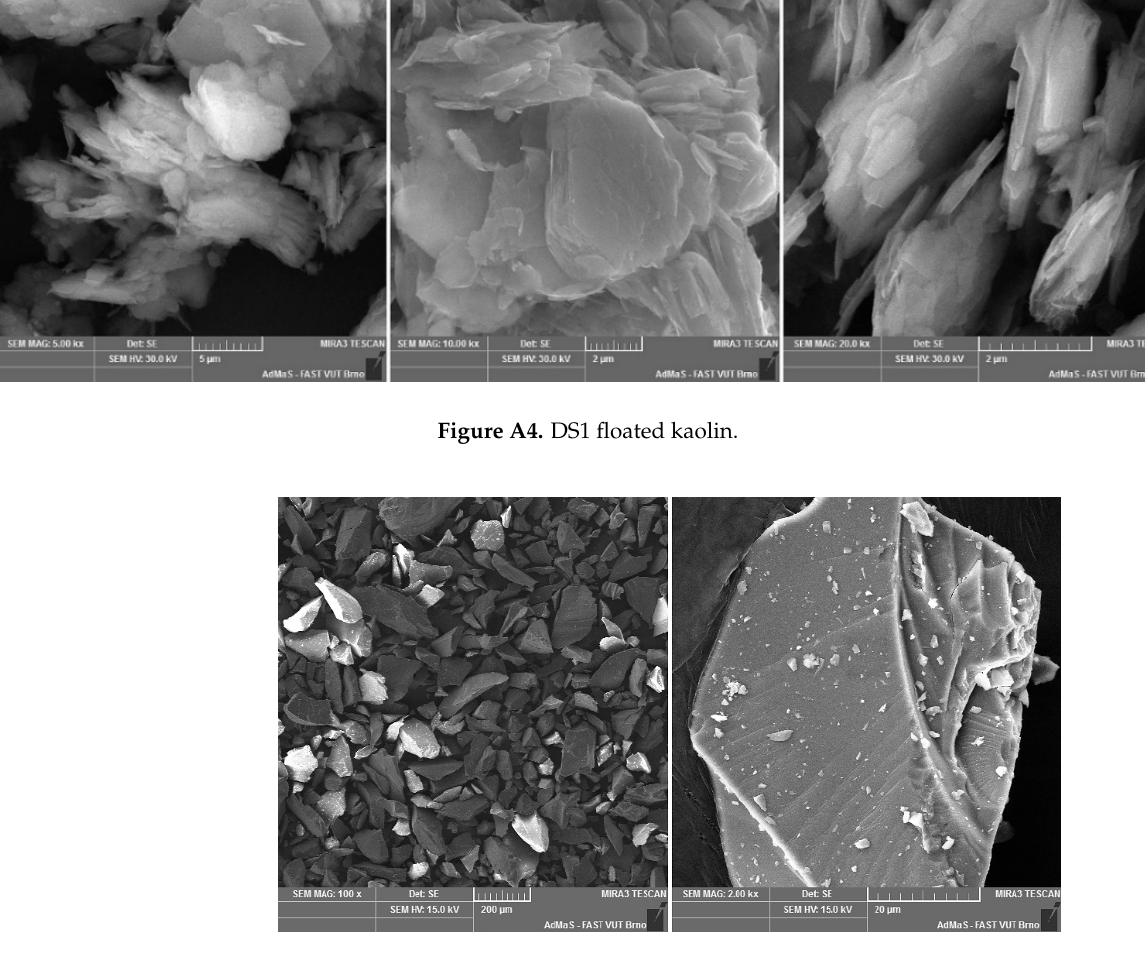
Figure A5. Mullite dust (MOTIM Electrocorundum company).